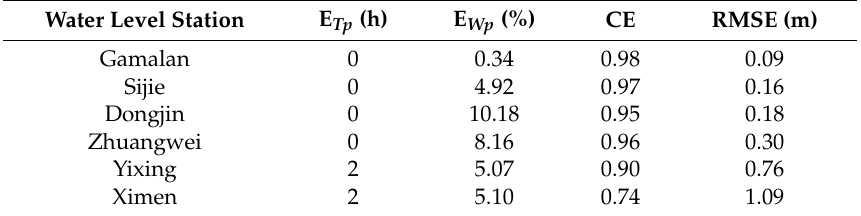
Table 2. E Tp , E Wp , CE and RMSE values for the water level: simulated results by SOBEK model.